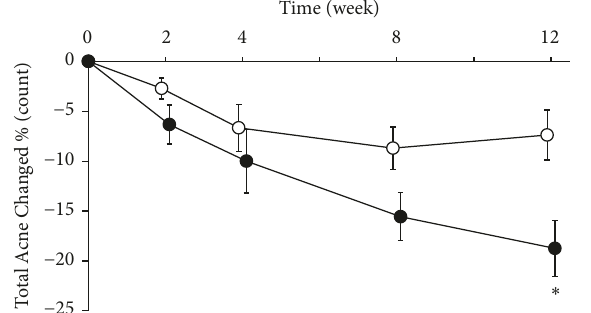
Figure 3: Effect of Keigairengyoto in a stratified analysis focusing on patients with disease duration of 2.6 years or more . Patients were randomized into a conventional treatment group (control group, white circle) and a group with conventional treatment and Keigairengyoto (KRT group, filled circle), and they were treated for 12 weeks. The median acne duration for all patients in this study was 2.6 years. The total sum of noninflammatory and inflammatory acne in patients with an acne duration of 2.6 years or more was examined. Although there was a difference in the number of patients among the groups, the KRT group showed significantly greater reduction in the amount of acne at week 12. For the change in inflammatory skin rash in patients with an acne duration of 2.6 years or more, the amount of inflammatory acne at 2, 4, and 8 weeks was lower in the KRT group compared with the control group, with a significant difference at 2 and 8 weeks. Data are shown as the mean ± standard error. The number of patients at each evaluation time point for the control and KRT groups is as follows: pretreatment: control 15 and KRT 9; week 2: 14 and 9; week 4: 9 and 9; week 8: 10 and 7; and week 12: 8 and 4. ∗ P < 0.05, Wilcoxon rank-sum